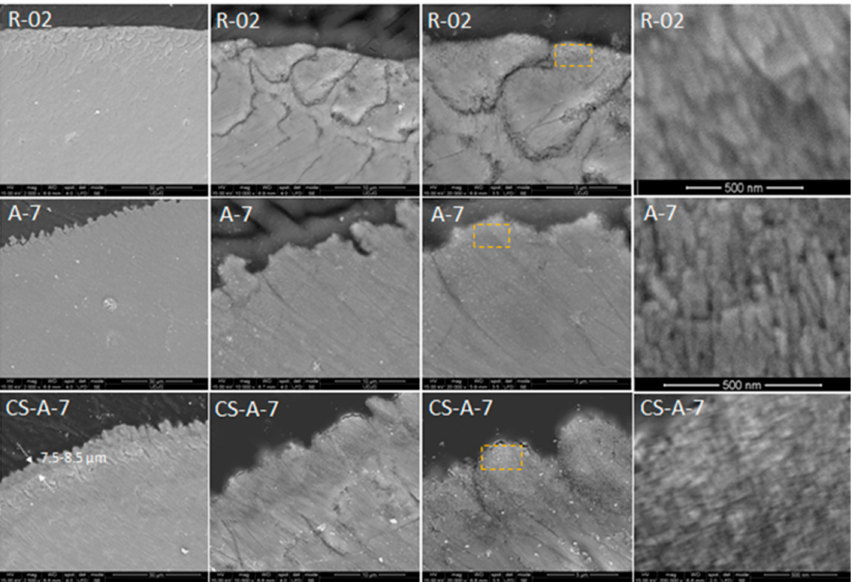
Figure 7. SEM image cross-sectional view of polished acid-etched natural reference enamel samples before (R-02) and after 7-day remineralization enamels in the presence of agarose (A-7) and chitosan– agarose (CS-A-7) hydrogels. (Yellow rectangle image is detailed on the right side.)